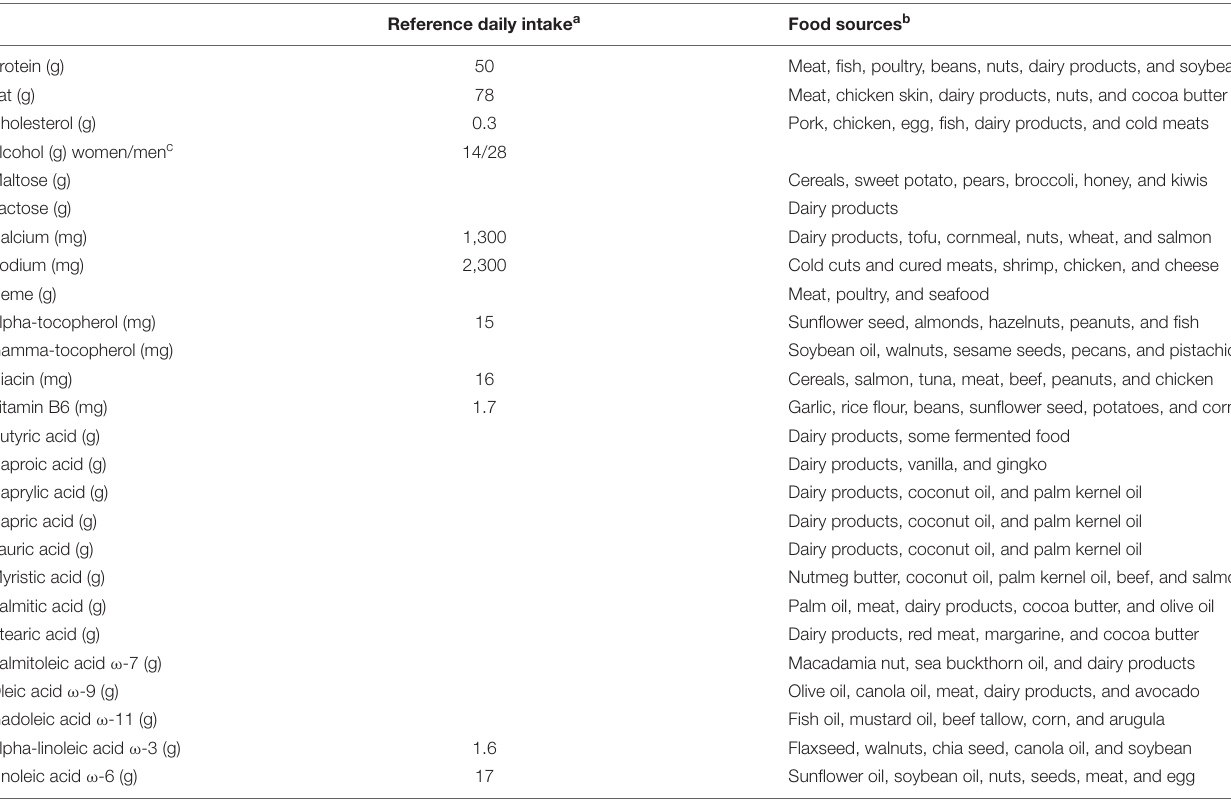
TABLE 10 | Reference daily intake and food sources of nutrients that influence